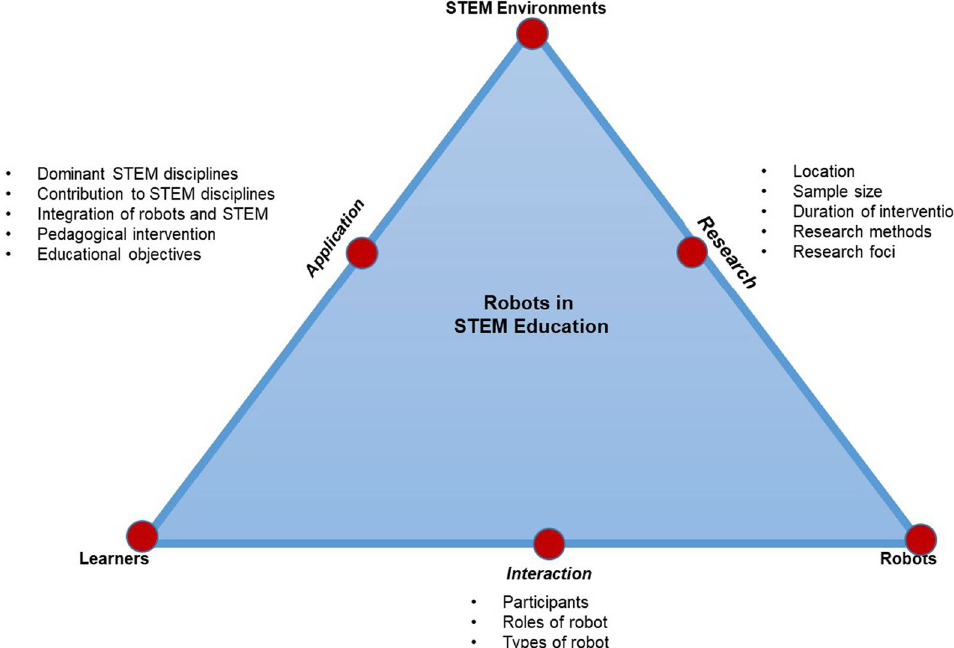
Fig. 2 Model of R‑STEM education theme